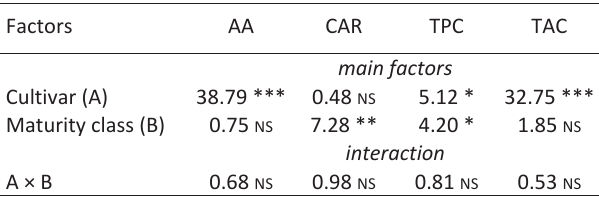
Table 3 - Multifactor analysis of variance (F-ratio and P-value) for ascorbic acid (AA), total carotenoids (CAR), total plenolic content (TPC) and total antioxidant